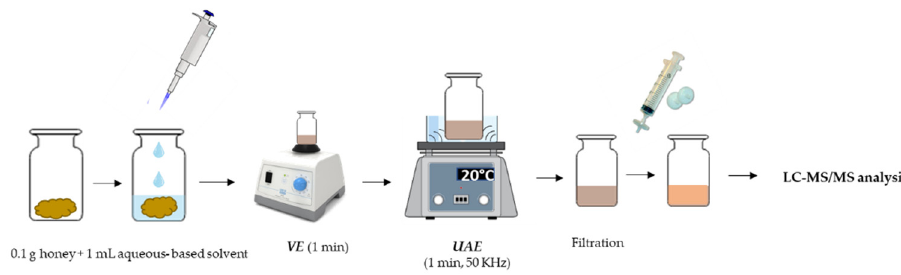
Figure 1. Schematic representation of the VE-UAE experimental